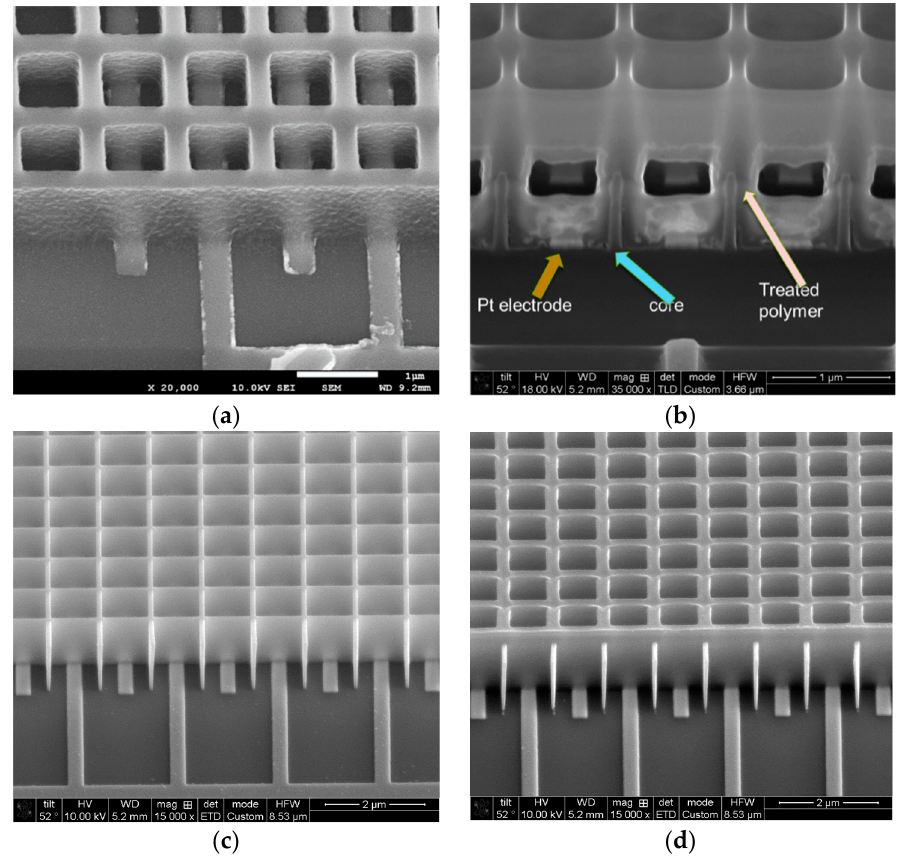
Figure 3. SEM micrographs showing key aspects of a fabricated device after infiltration. ( a ) Image shows a 1 μ m tall–300 nm wide mesh structure over a set of interdigitated electrodes. ( b ) Image of the same device after focused ion beam (FIB) cross sectioning exposing the dielectric core, Pt electrodes, and infiltrated SU-8 polymer. ( c , d ) Devices fabricated with extra dielectric core fins to ensure electrical current goes over the core into the sensing media ( c ) device with only a core and no polymer, and ( d ) device with core and polymer.